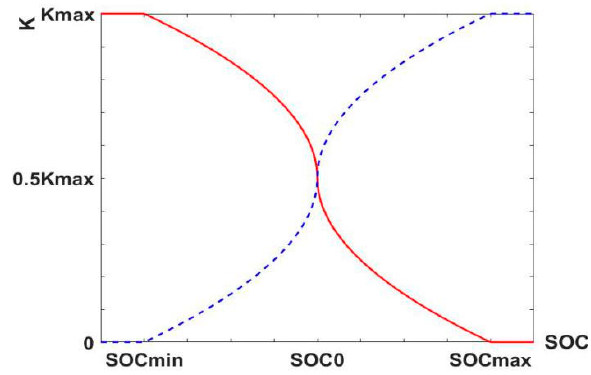
Figure 2. Control coefficient curve.